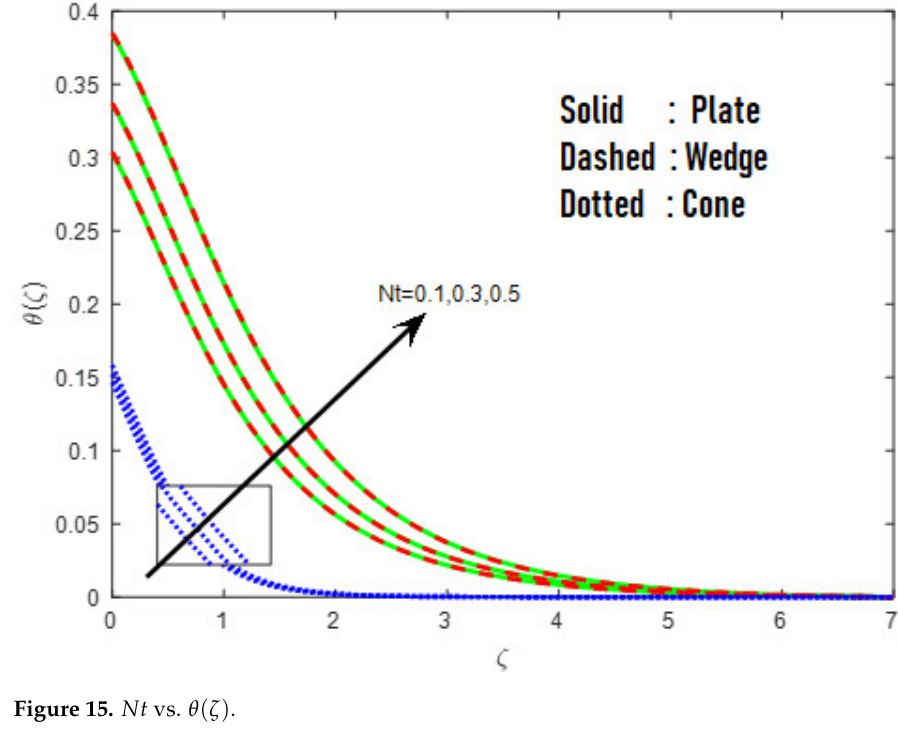
Nt vs. Figure 15. Nt vs. θ ( ζ ) . Figure 15. Figure 15. Nt vs.     .